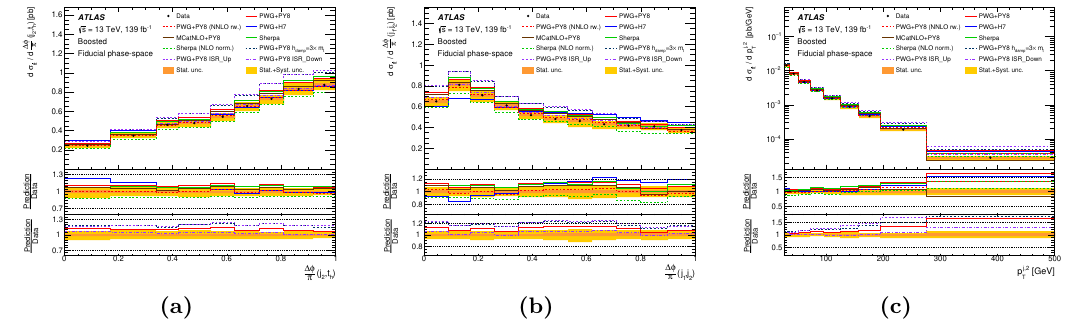
Figure 13. Differential cross-section measurements for the observables probing the second leading additional jet. The cross-section is shown as a function of (a) ∆ φ ( j . In each plot the data are compared with predictions from various MC generators. PWG+PY8 p j, 2 T corresponds to the Powheg+Pythia sample, PWG+H7 to the Powheg+Herwig sample and MCatNLO+PY8 to the MadGraph5_aMC@NLO+Pythia sample. The orange band shows the size of the statistical uncertainty and the yellow band shows the size of the total uncertainty. The lower two panels in each subfigure display the ratios of the different predictions to the